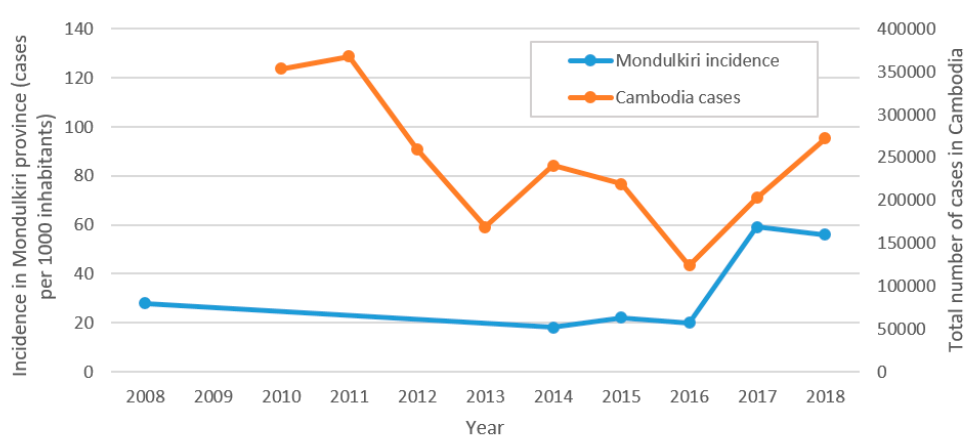
Figure 4. Malaria incidence data for Cambodia (total number of estimated cases) and Mondulkiri province (cases per 1000 inhabitants).